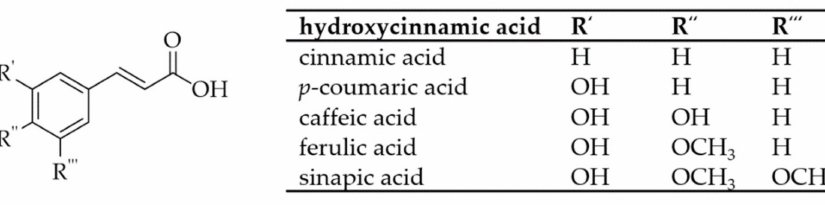
Figure 2. The structures of hydroxycinnamic acid